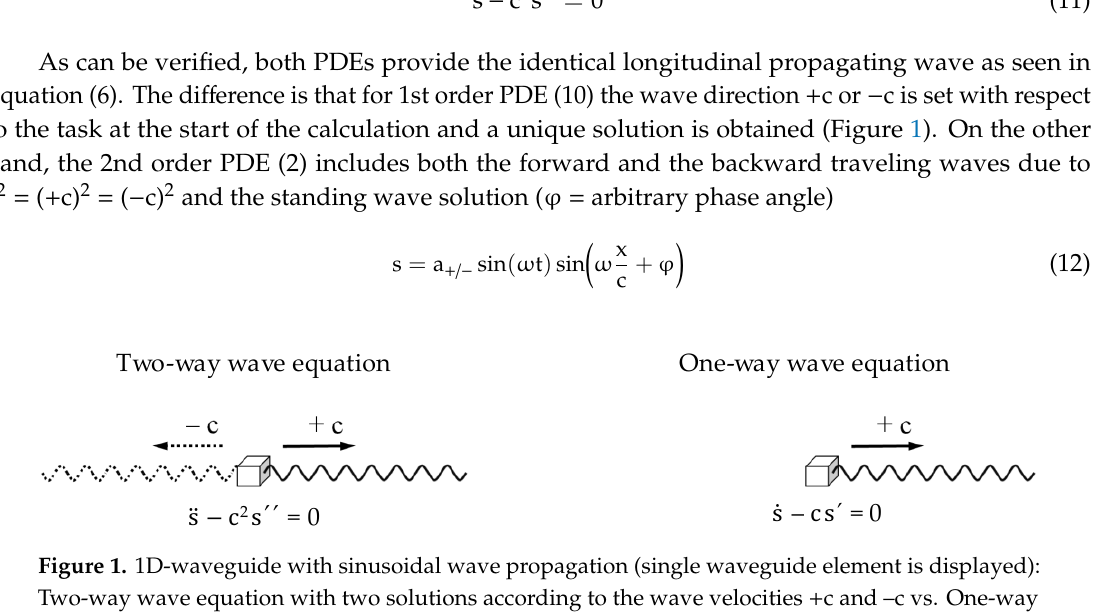
Figure 1. 1D-waveguide with sinusoidal wave propagation (single waveguide element is displayed): Two-way wave equation with two solutions according to the wave velocities + c and – c vs. One-way wave equation with one unique solution acc. to the chosen wave velocity c (here: + c ).